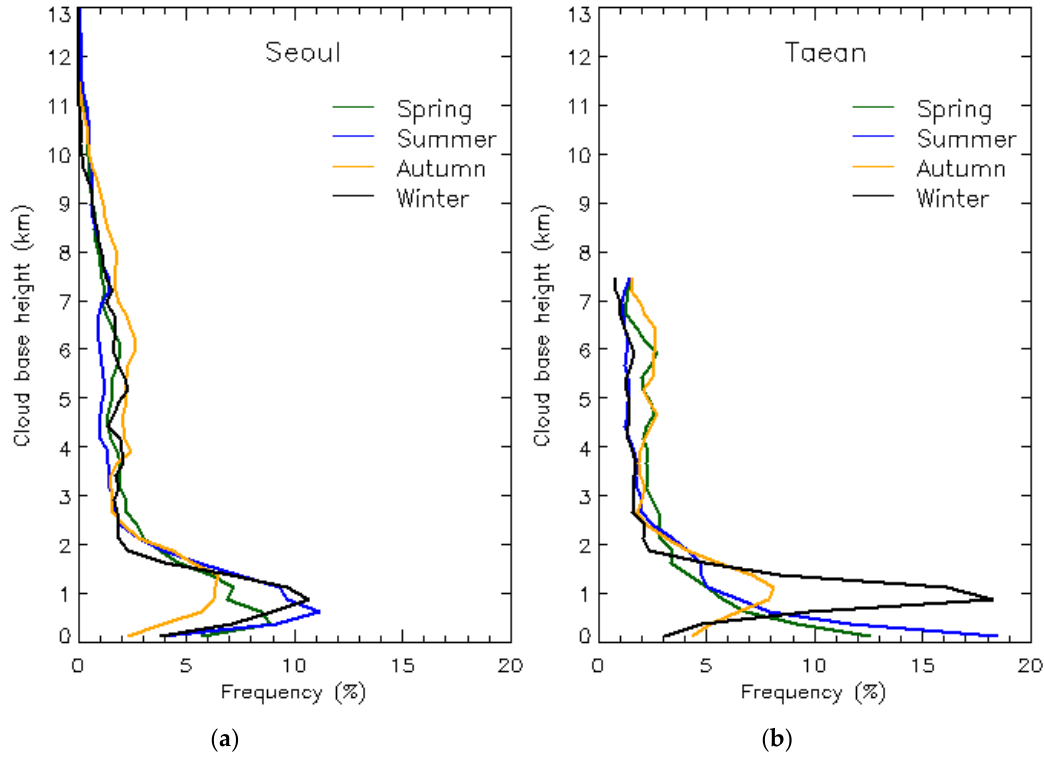
Figure 6. Seasonal vertical distributions of cloud occurrence at ( a ) Seoul and ( b ) Taean for the entire period.